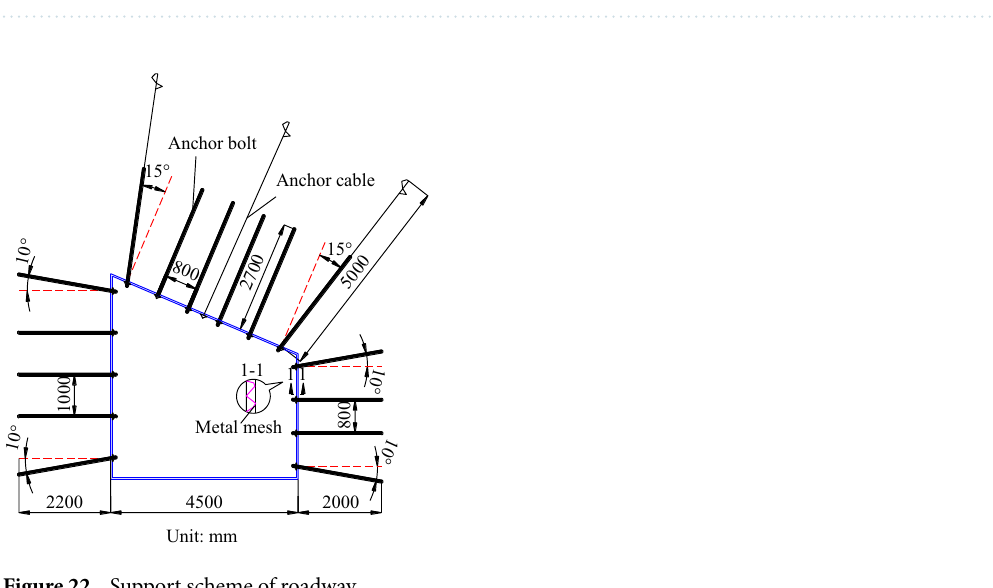
Figure 21. Loose circle of two sidewalls of roadway.